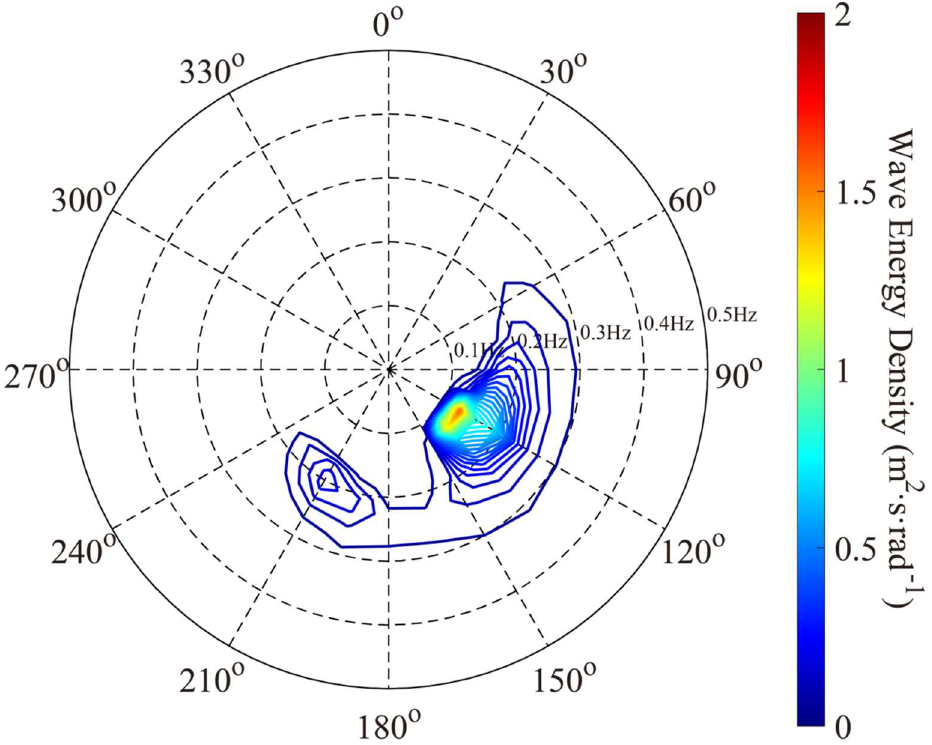
Figure 8. The wave energy density at the point (19.5° N, 107.5° E) in Typhoon Doksuri at 6:00 a.m. UTC on 16 September 2017.